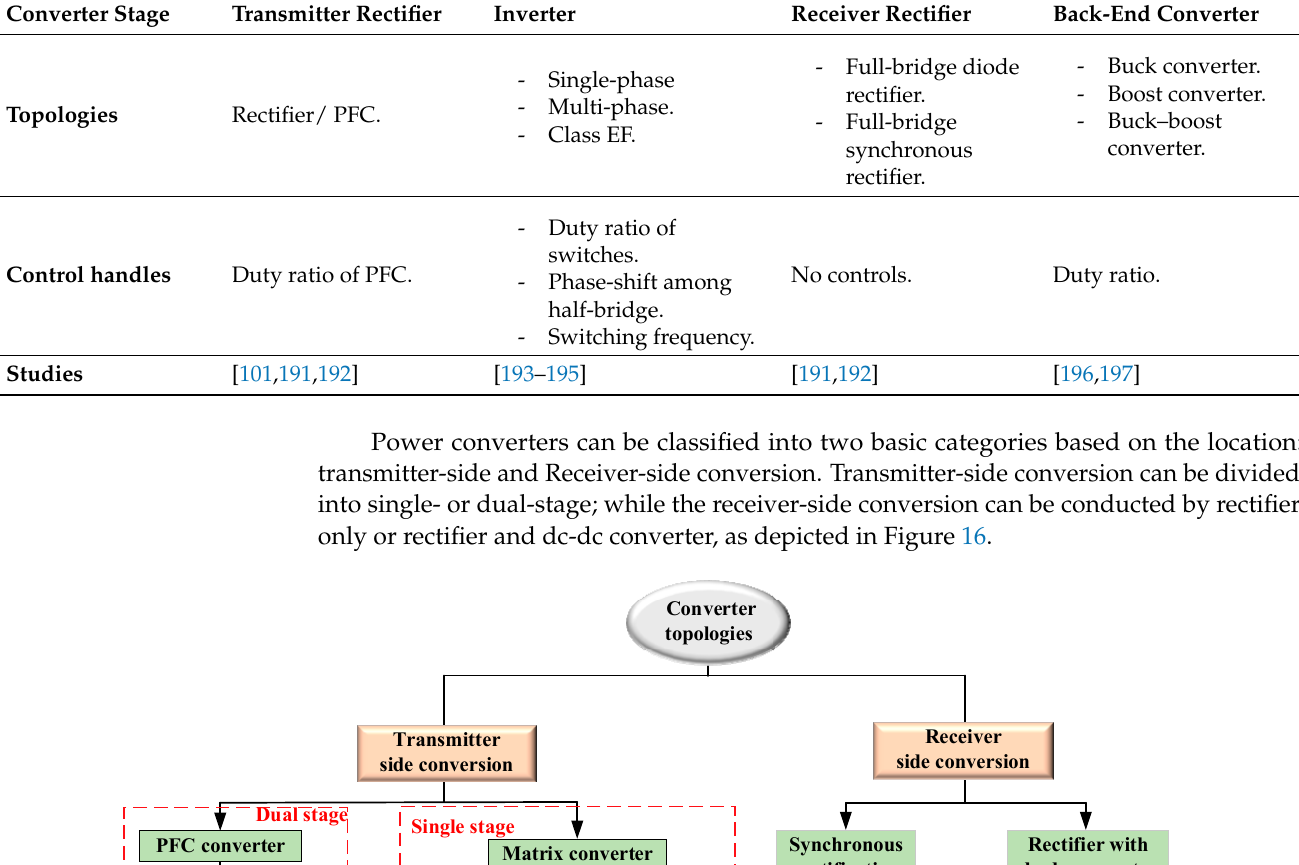
Table 7. Conversion stages for DIPT with associated topologies and control handles.